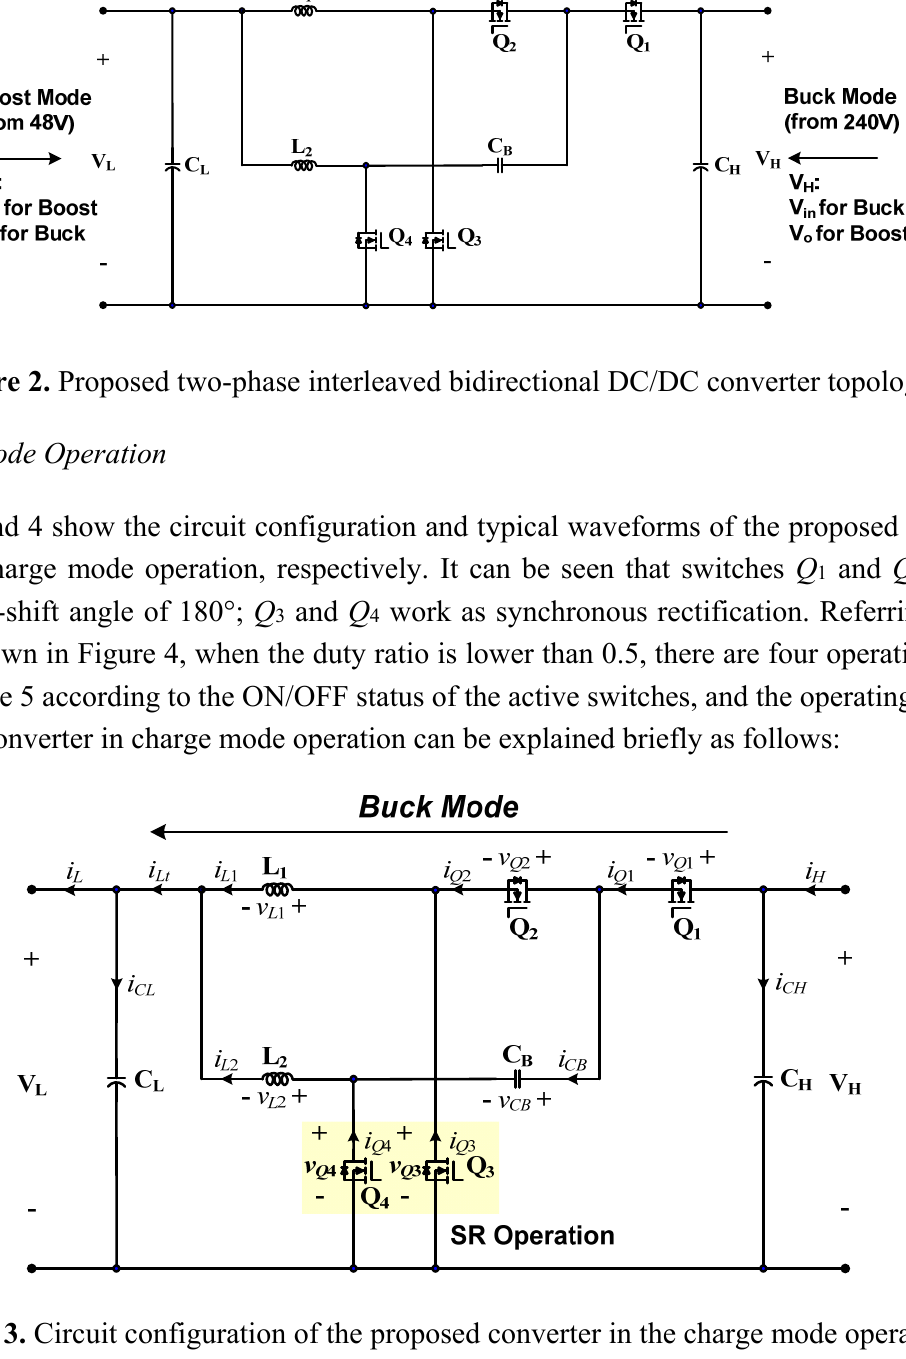
Figure 3. Circuit configuration of the proposed converter in the charge mode